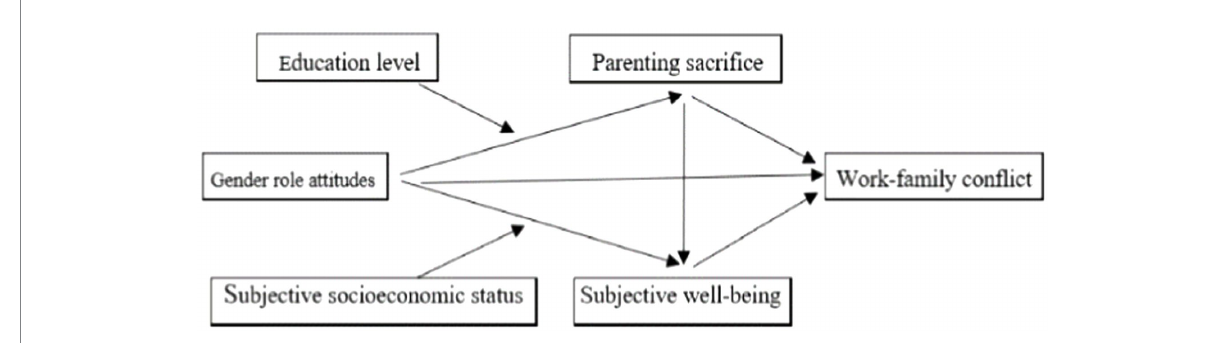
FIGURE 1 The relationship between gender role attitudes, parental sacrifice, subjective well-being, and work–family